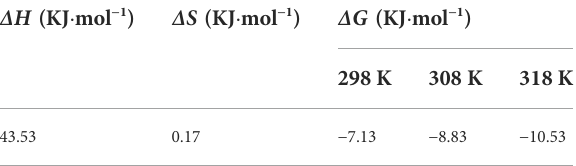
TABLE 3 Thermodynamic analysis and fi tting